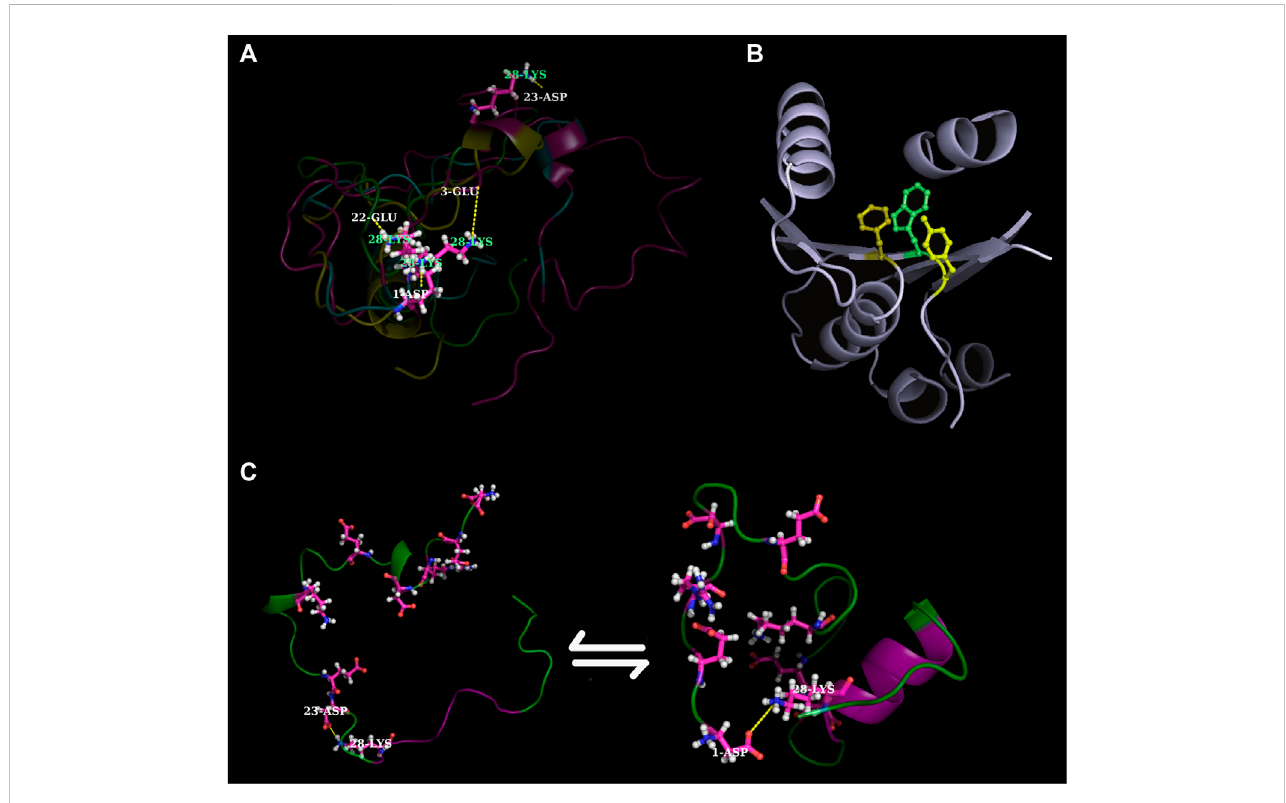
FIGURE 1 Recent fi ndings in contemporary protein design across the globular — disorder evolutionary interface. (A) shows ephemeral salt-bridge dynamics in IDPs (in relation to administering cumulative mutations in probing disorder-to-order transitions in IDPs) (Basu and Biswas, 2018). (B) shows a 3-clique (Basu et al., 2011), a ubiquitous packing motif in densely packed cores that heavily in fl uences the formation and sustenance of alternatively packed hydrophobic cores withinthesameproteinfold(Biswasetal.,2022). (C) showshowA β 42 temporarilyshapesintopartialorderduringitsmoleculardynamicsimulations(Basu and Biswas, 2018). Images in (A,C) have been reconstructed from scratch using suitable MD simulation snapshots. In contrast, the image in (B) have been reproduced with appropriate copyright permissions from BMC